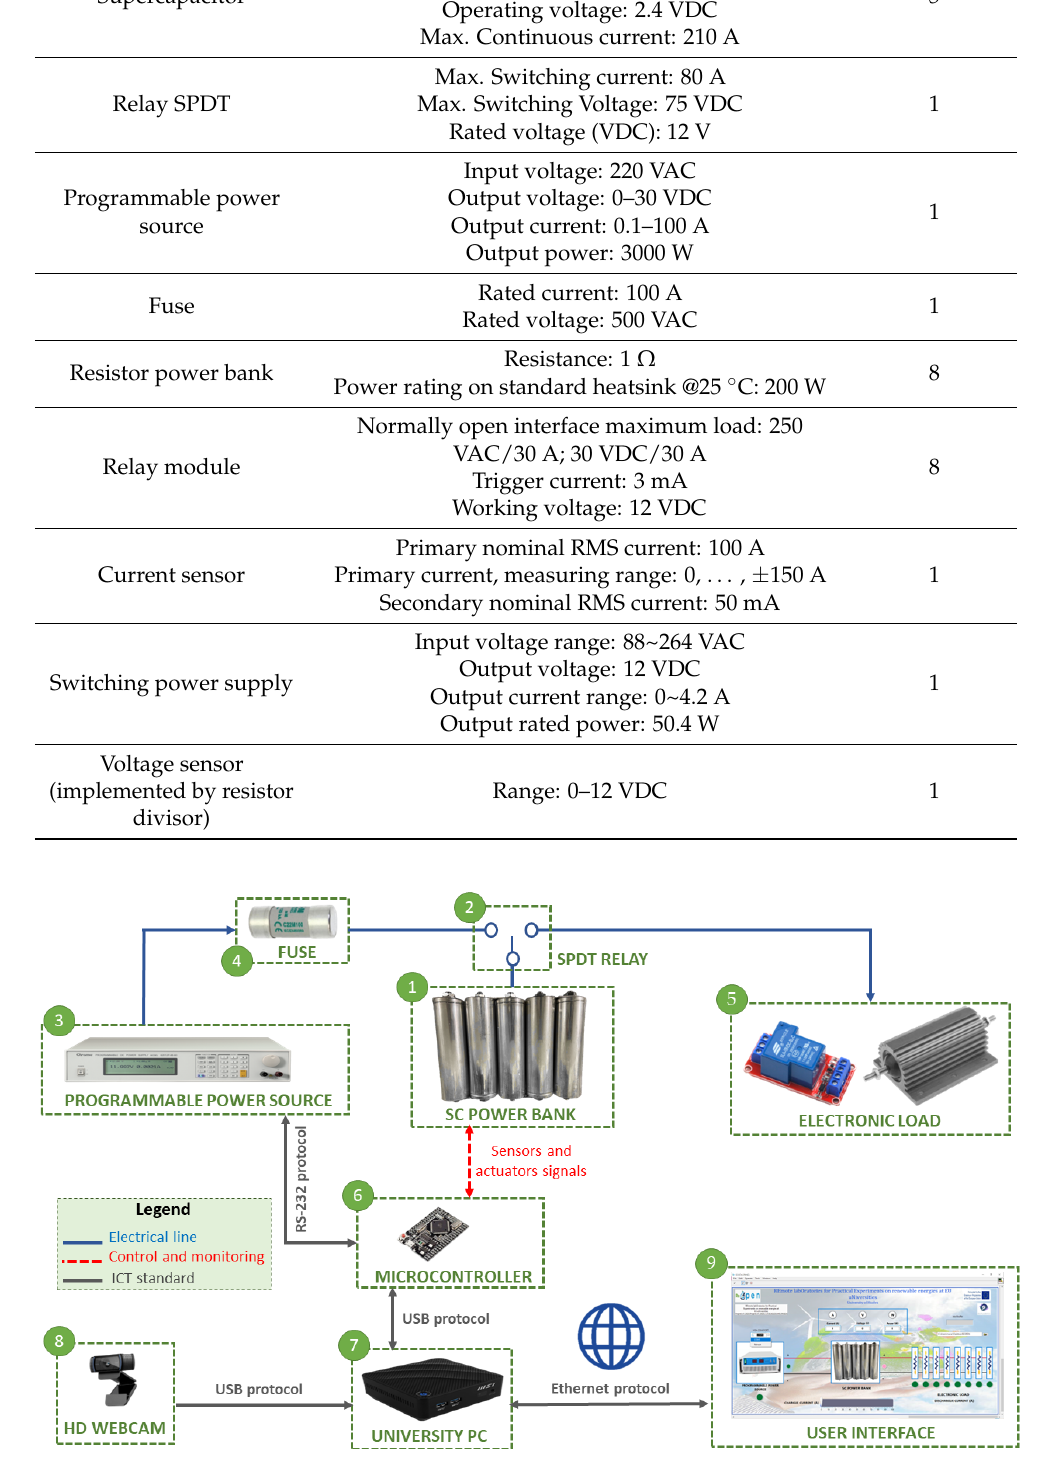
Figure 7. Supercapacitor test bench. Electrical layout. The technical specifications of each component used in the supercapacitor test bench are shown in Table 2. The physical implementation of the supercapacitor power-bank-based remote labor- atory is shown in Figure 8. The image on the left shows the charging process of the super- capacitor power bank, and the image on the right shows the process of the discharging cycle.